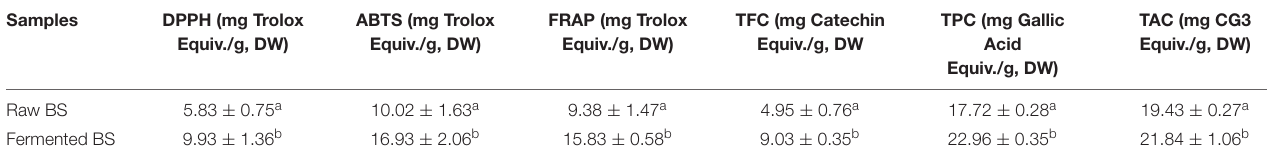
TABLE 1 | Antioxidant activity (DPPH, ABTS, and FRAP), total flavonoid content (TFC), total phenolic content (TPC), and total anthocyanin content (TAC) of raw and fermented black soybean extracts. Samples